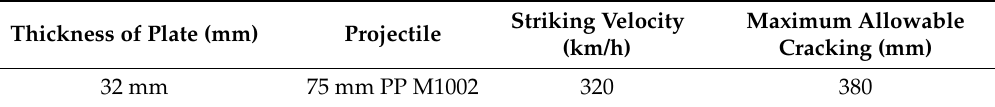
Table 8. Results of the ballistic tests.